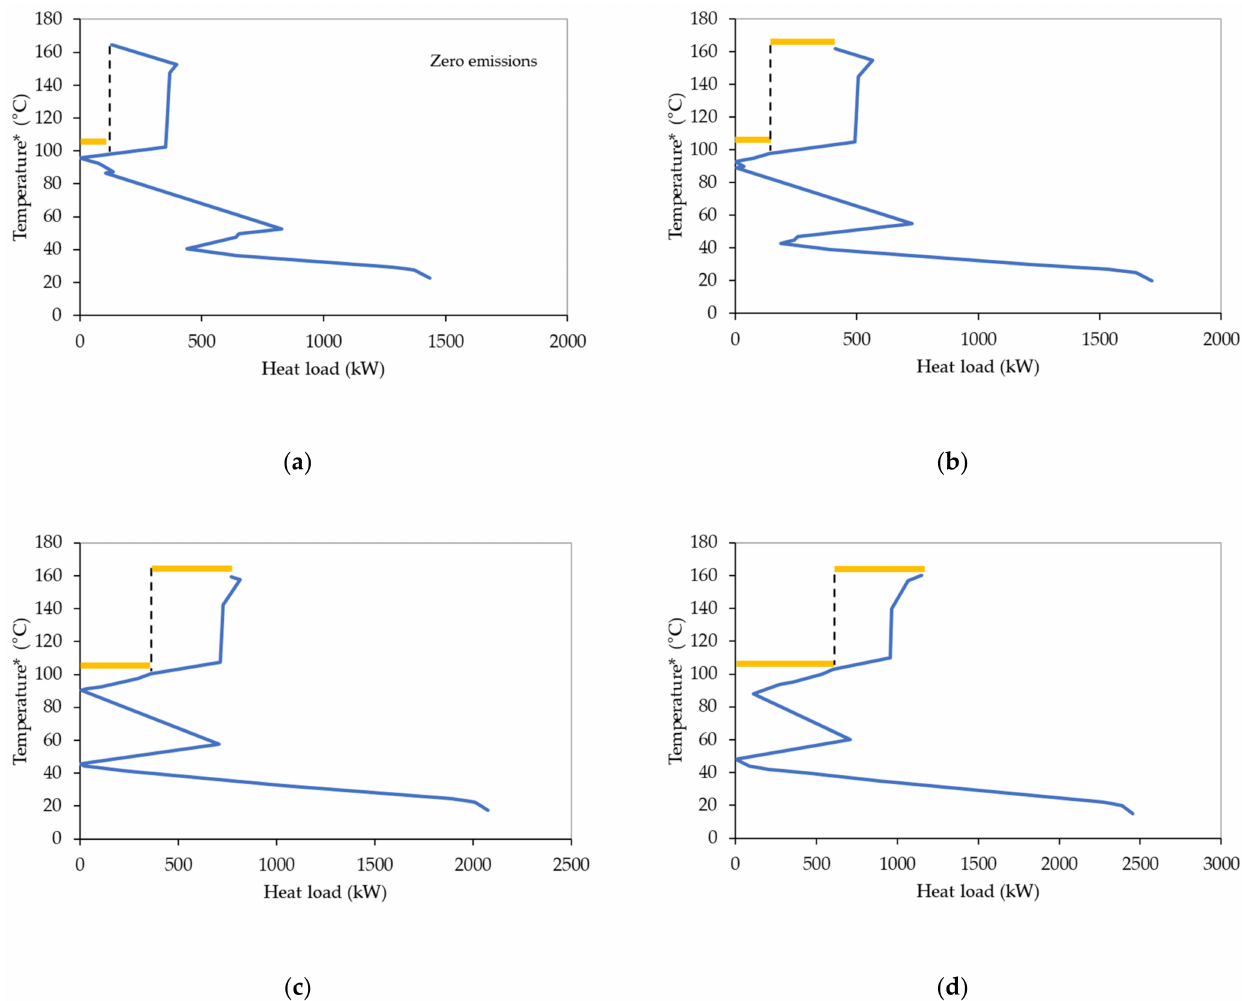
Figure 3. Grand composite curves for different ∆ T min that show how it is possible to supply the total heat process in the 1G and 2G bioethanol production described lines above. ( a ) ∆ T min of 5 ◦ C; ( b ) ∆ T min of 10 ◦ C; ( c ) ∆ T min of 15 ◦ C; ( d ) ∆ T min of 20 ◦